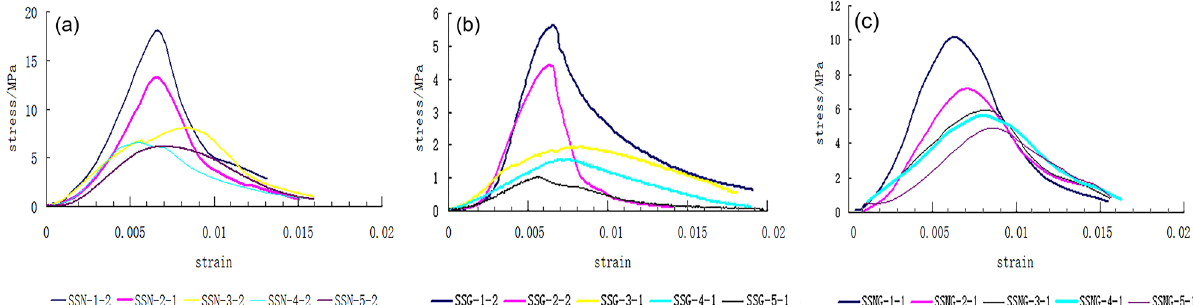
Figure 1. Stress–strain curves of ( a ) SSN, ( b ) SSG, and ( c ) SSNG rock-like